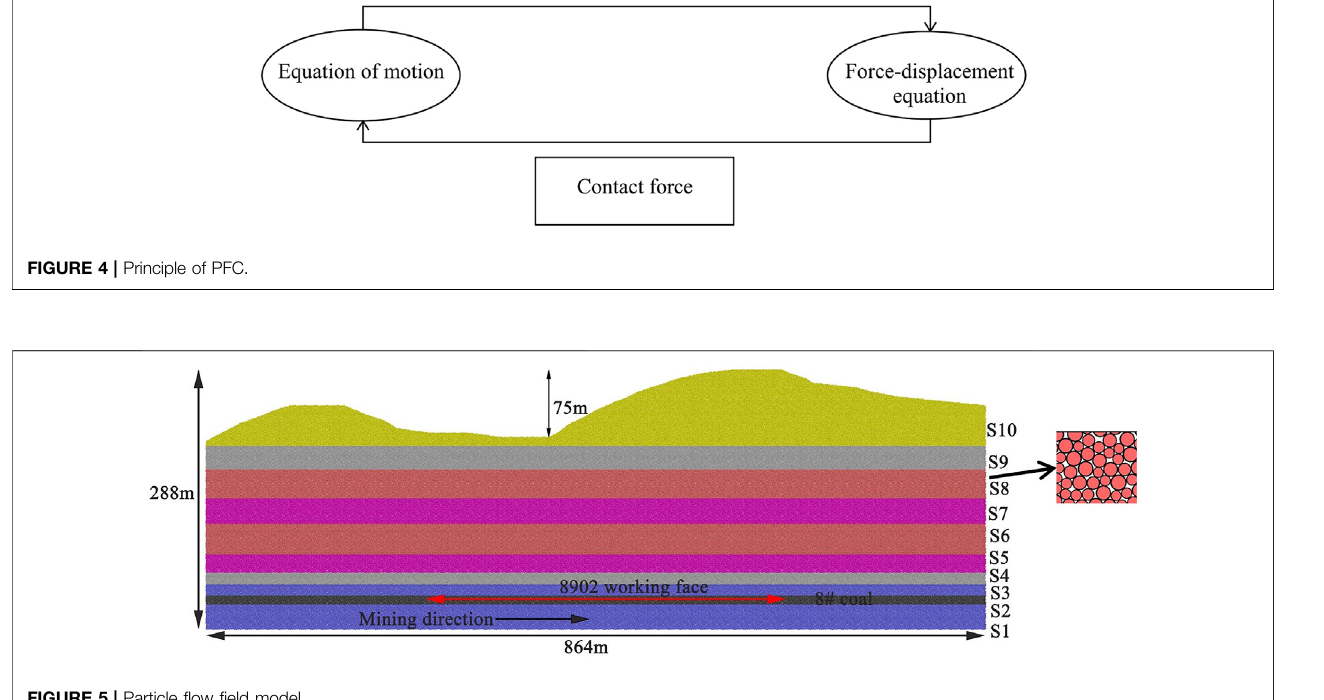
FIGURE 5 | Particle fl ow fi eld model.